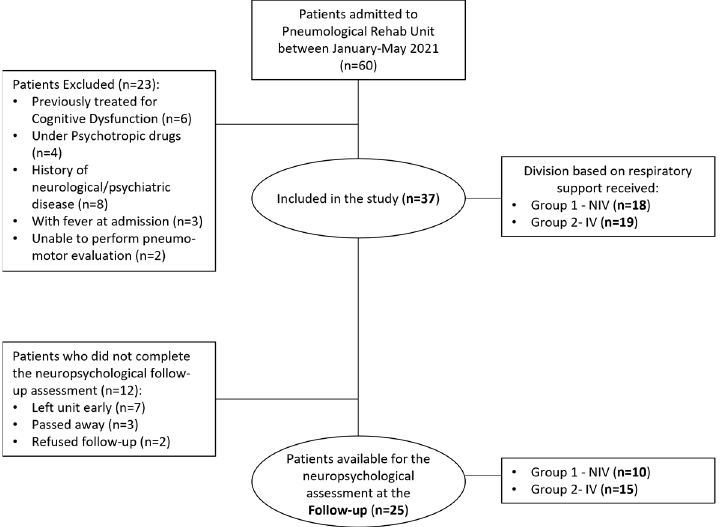
Figure 1. Flow-diagram for the recruitment of patients in the post-COVID cognition assessments.